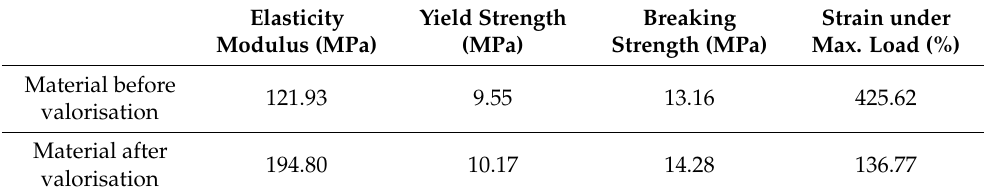
Table 2. Mechanical properties of polyethylene before and after being recycled.